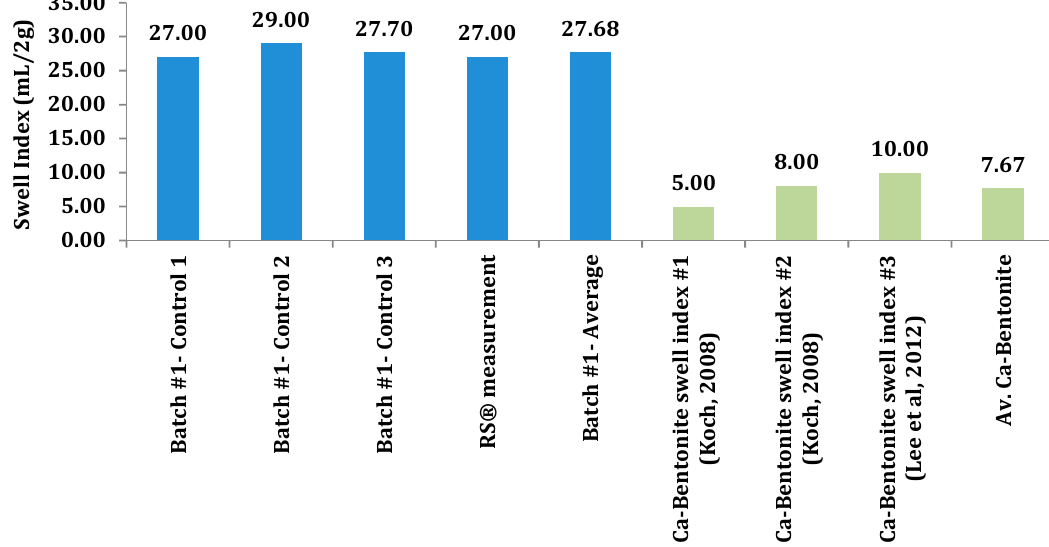
Figure 3. Control swell index results, along with a comparison to a Ca-type bentonite.